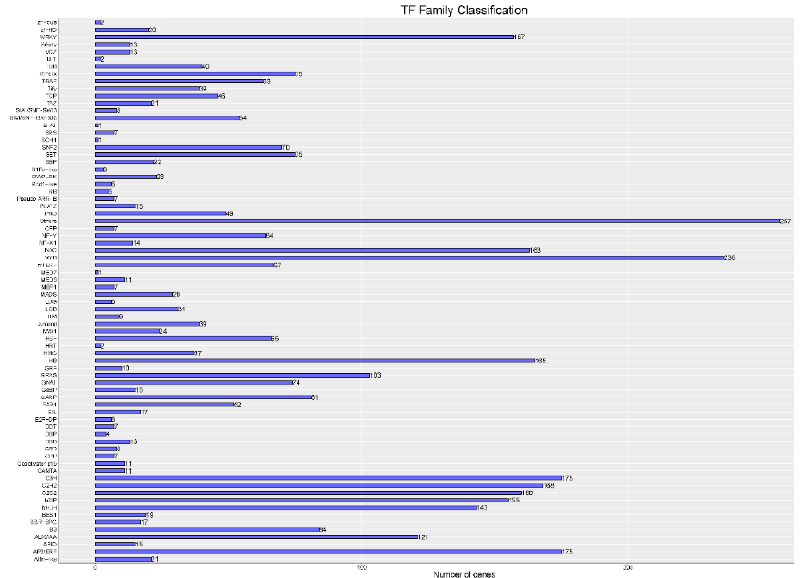
Figure 4. Transcription factor analysis . The ordinate shows different transcription factor families, and the abscissa depicts the number of the transcription factor families.